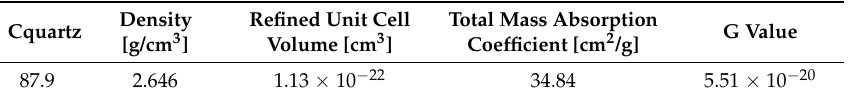
Table 4. G Value Calculation Based on Rietveld Refinement of Quartz Rock.